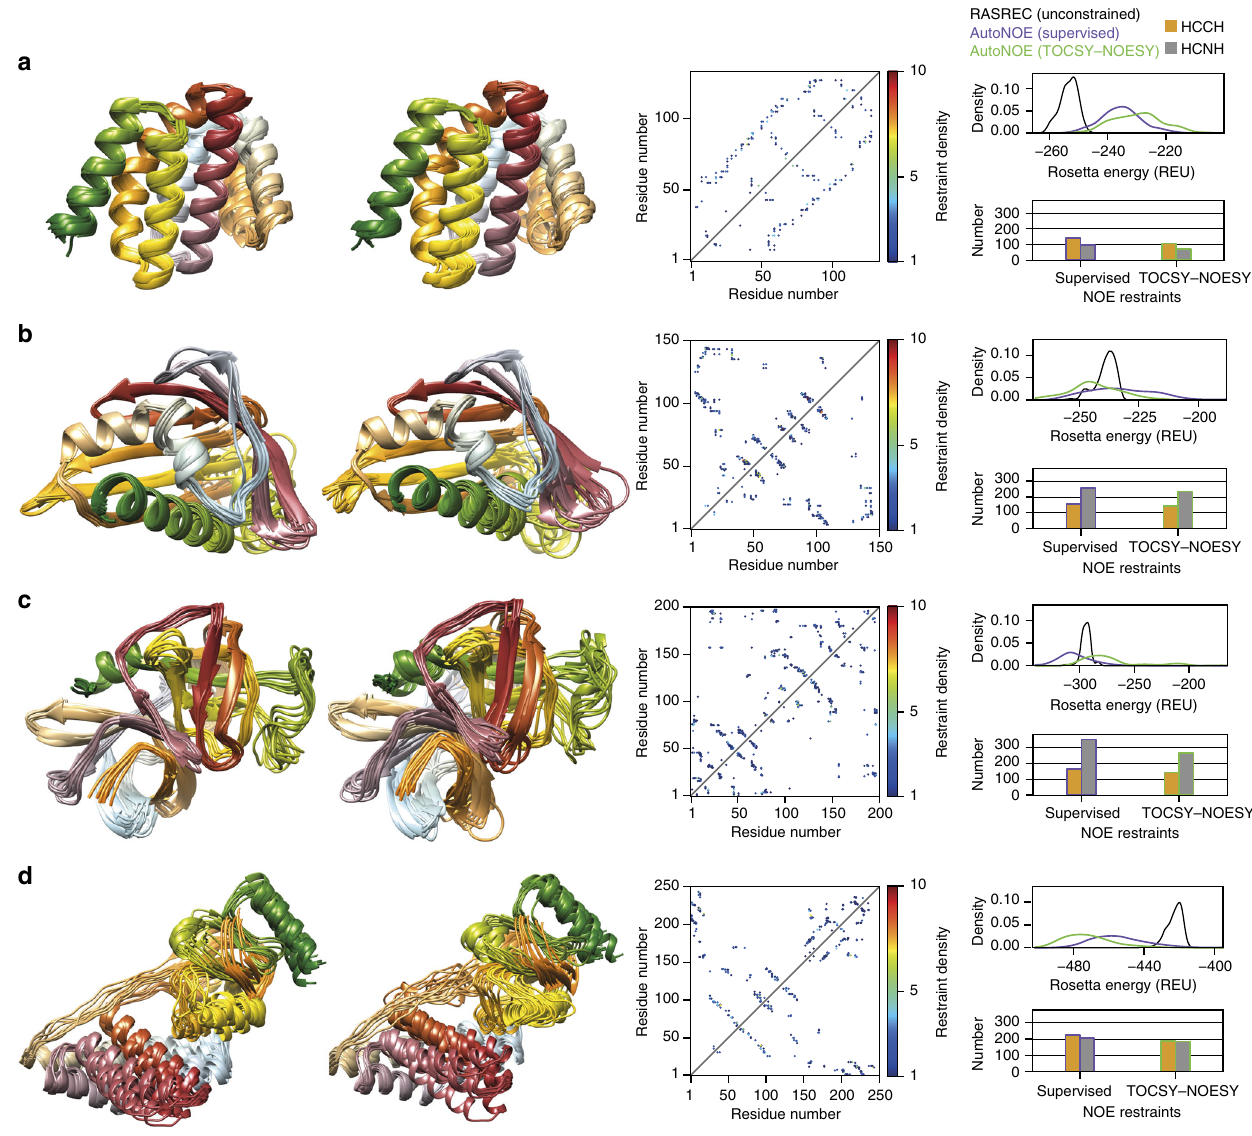
Fig. 5 Comparison of structural ensembles calculated from supervised versus fully automated assignments. a Rtt103 (RTT, 133 aa), b KanY (ms6282, 145 aa), c α -lytic protease (aLP, 198 aa) and d Enzyme I (nEIt, 248 aa). Columns 1 and 2: autoNOE-Rosetta ensembles of 10 lowest-energy structures guided by “ best effort ” supervised assignments or by automated 4D-CHAINS assignments (TOCSY – NOESY), respectively. Column 3: Sequence map of distance restraints assigned by autoNOE-Rosetta in iterative structure re fi nement calculations. Here, the upper triangular region shows restraints obtained using supervised assignments, while the lower triangular region using automated 4D-CHAINS assignments. Column 4: Rosetta energy (in Rosetta Energy Units (REU)) distributions and total numbers of assigned long-range restraints. The energy distribution was computed from the 100 lowest-energy structures sampled during the fi nal stage of autoNOE-Rosetta calculations using supervised assignments (purple), 4D-CHAINS assignments (green) and chemical shift fragment-based RASREC-Rosetta calculations without NOEs (black). The bars represent the total number of HCNH (amide to aliphatic) and HCCH (aliphatic to aliphatic) long-range NOE restraints assigned by autoNOE-Rosetta, including ambiguous restraints derived for different stereo-speci fi c groups. RDCs were used to obtain converged Enzyme I structures with respect to the orientation of the two domains reported in row d . Images of structural ensembles were produced using Chimera Sparse sampling and data processing . The on-grid Poisson disc sampling 36 was Peak picking . Peaks were picked automatically and curated manually using a utilized in the present application to distribute individual acquisition points in the restricted peak picking strategy. First, the 4D-HCNH NOESY spectrum was picked indirectly detected dimensions. This sampling scheme introduces distances at a user-de fi ned noise level using both 15 N, 1 H- and 13 C, 1 H-HSQC peaks as fi lters. between the generated time points and has been shown to reduce the level of Then the 4D-HCNH TOCSY spectrum was picked using the 4D-NOESY peaks as fi lters. Accordingly, all planes were inspected simultaneously in all spectra and sampling artifacts in the direct vicinity of signal after the reconstruction 36 . The 4D data were processed using sparse Fourier transform algorithm 37 to picked artifacts were removed. Synchronization of all four shared dimensions in check the data quality. Final processing was performed in an iterative manner using the spectra allows for a highly ef fi cient peak picking and curation process. the Signal separation analysis approach as implemented in the program cleaner4d 37 (SSA package). Prior to processing with the cleaner4d program, the data were square cosine weighted in the directly acquired dimension and zero- fi lled Measurement of RDC restraints for nEIt . Backbone amide 1 D NH RDCs were to 2k points using NMRPipe/NMRDraw 3.0 38 . The 4D spectra were analyzed in measured by taking the difference in 1 J NH scalar couplings in aligned and isotropic Sparky 39 . media 40 . The alignment media employed was phage pf1 (16mg ml − 1 ; ASLA